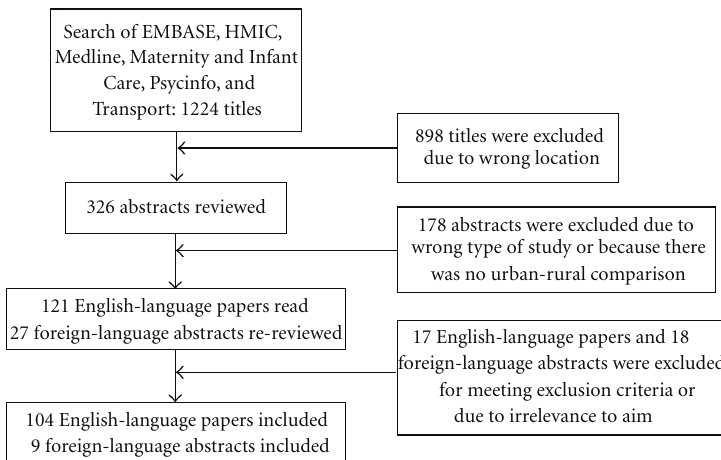
Figure 1: Flow chart of study selection